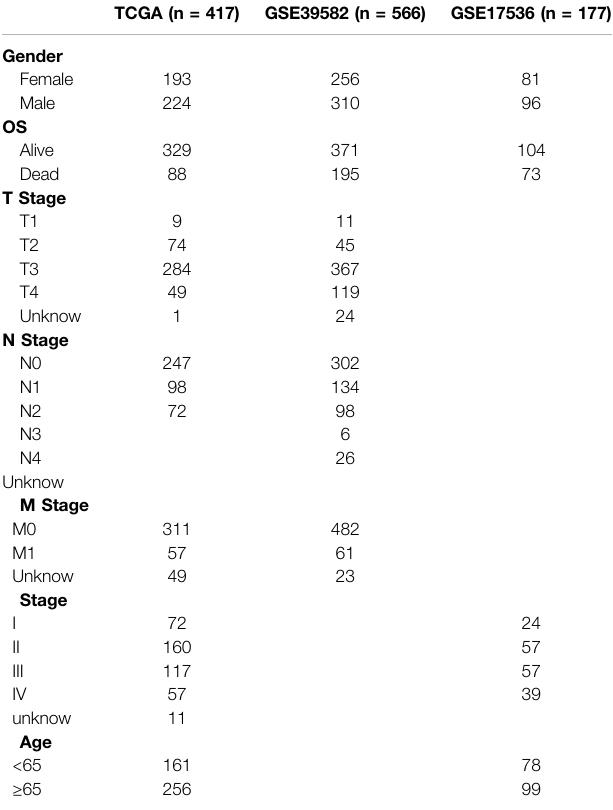
TABLE 1 | Information on patients included in this